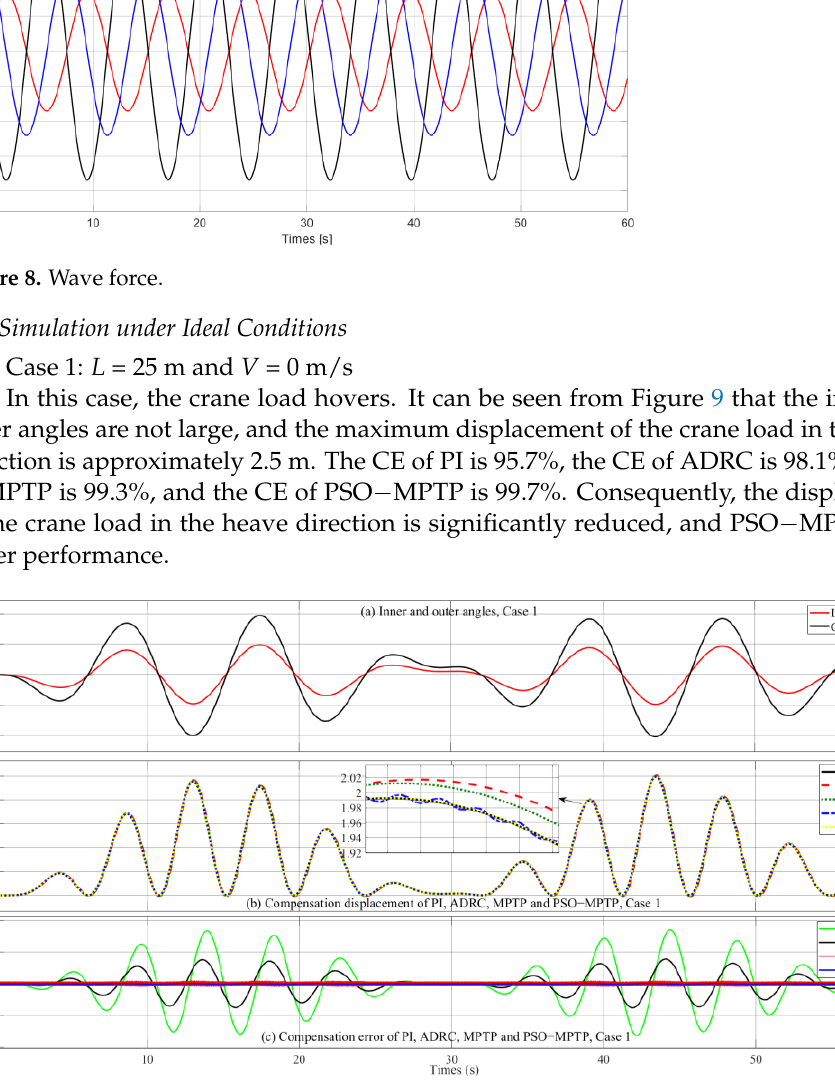
Case 2: L = 25 m and V = 0.2 m/s